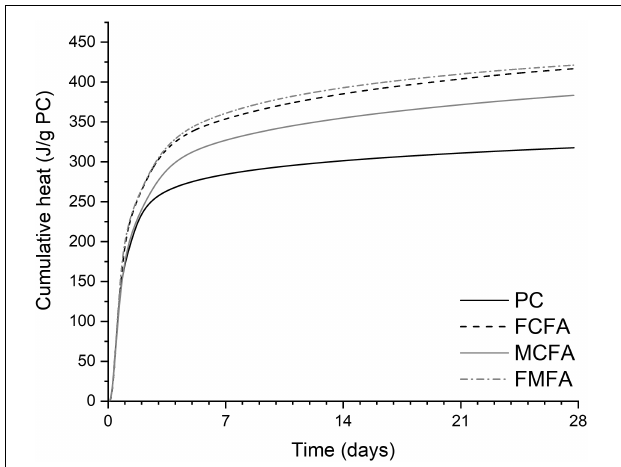
FIGURE 4 | Cumulative heat of hydration of the fly ash blended cements and the control Portland cement, values are expressed as J/g of Portland cement.